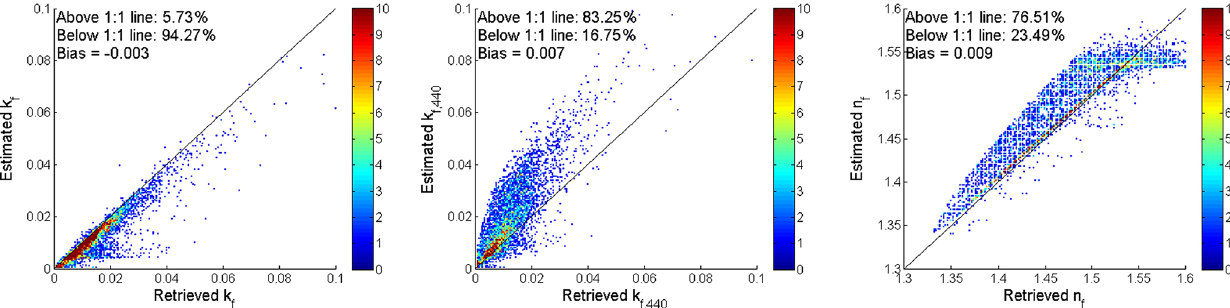
Figure 8. Data pair frequency of instantaneous imaginary parts of the complex refractive index at 675nm ( k f ) and 440nm ( k f , 440 ) and the real part at 440nm ( n f ) which are sorted according to ordered pairs (retrieved, estimated) in 0.0005 and 0.001 intervals for imaginary and real parts, respectively. “Retrieved” represents the subcomponent of the CRI from the optical–physical retrievals, and “estimated” is estimated by retrieved chemical components. The color represents the number of cases (color bar), and the solid black line shows the 1 : 1 line.